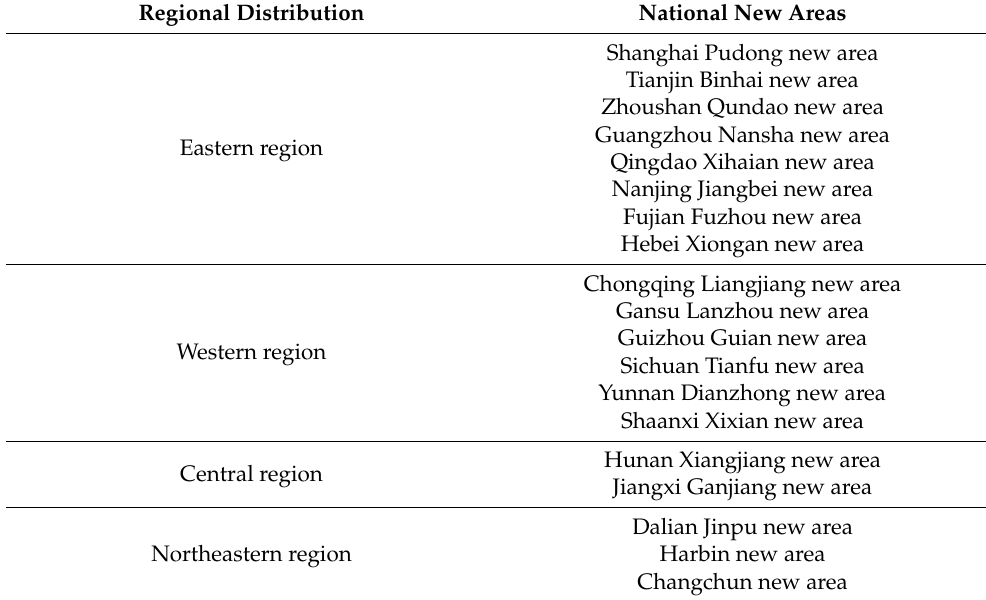
Table 1. Regional Distribution of National new